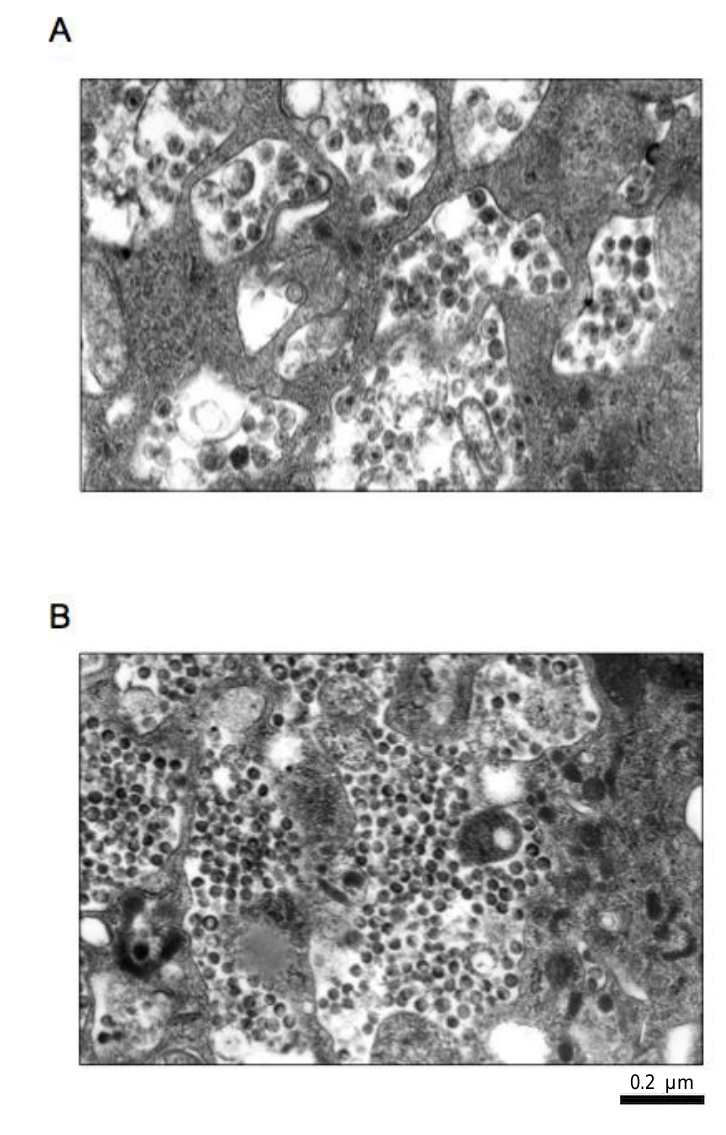
Figure 2. Photographs of electron microscopy representing: ( A ) viral particles contained in cytoplasmatic vacuoles in untreated HIV-1-infected macrophage; ( B ) immature virus particles contained in cytoplasmatic vacuoles in AMP-treated HIV-1-infected MDM.